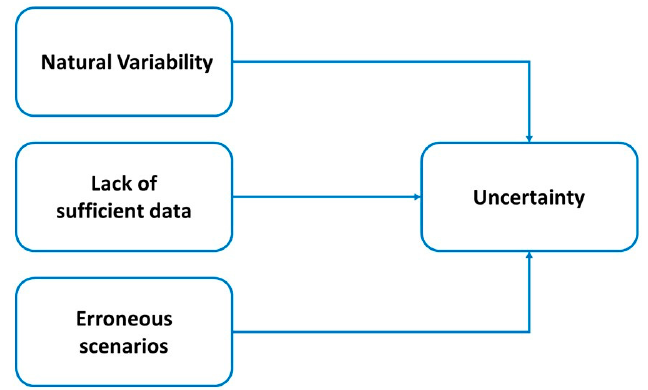
Figure 1. Schematic representation of various parameters affecting the uncertainty of a climatic